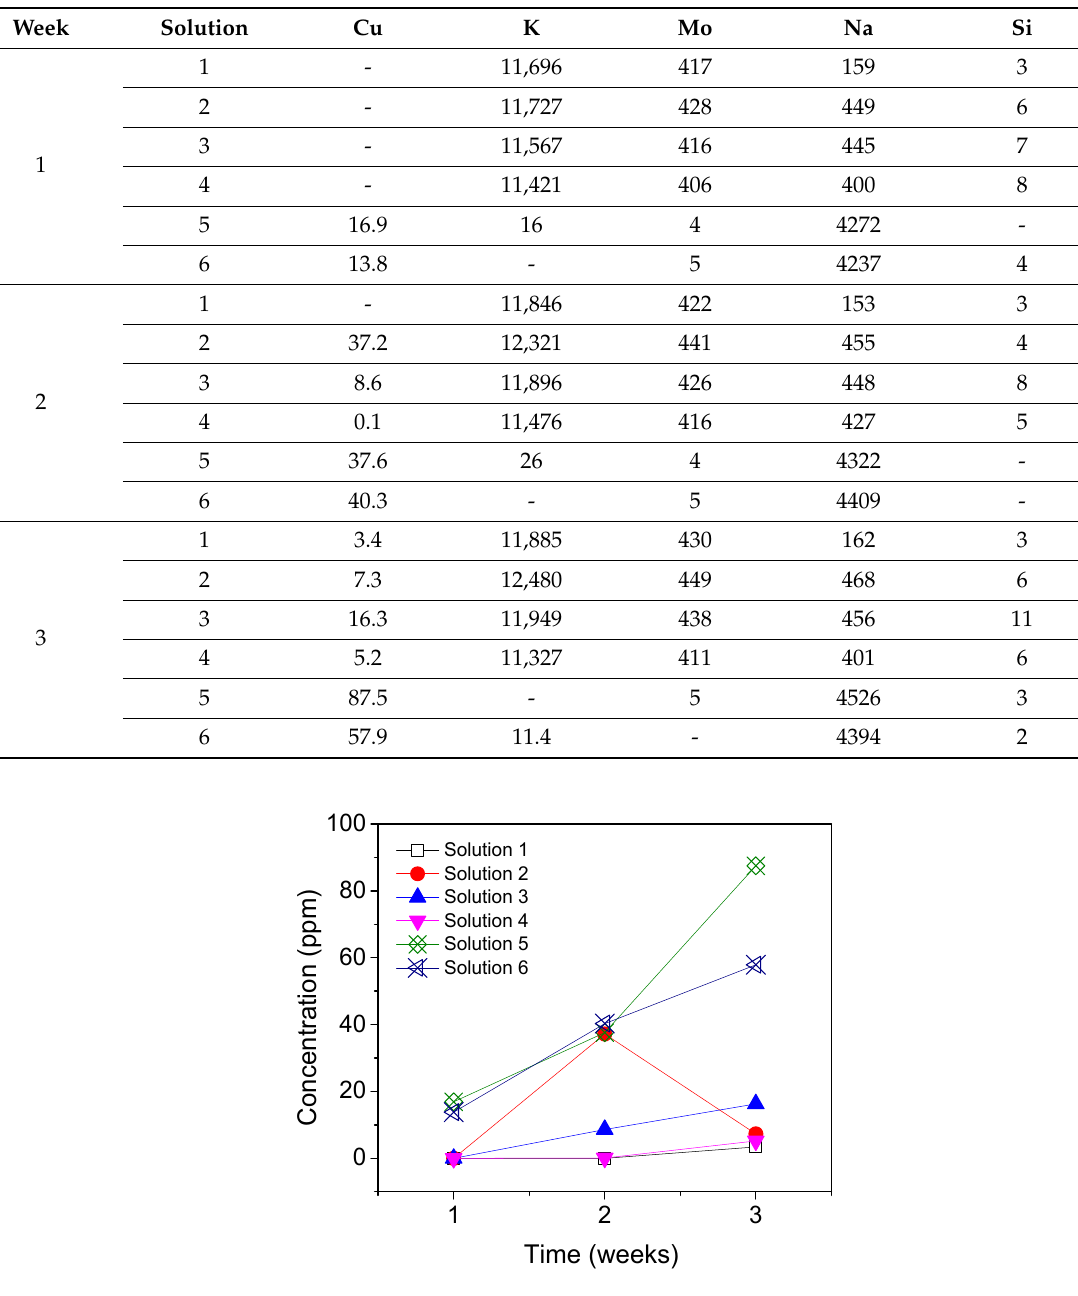
Figure 2. Concentration of Cu ion in the solution as a function of immersion time. After 2 weeks, about 40 ppm of Cu ions were dissolved in solutions no2, no5, and no6. Cu + or Cu 2+ ions are not thermodynamically stable in water with pH 7~13, referring to the Pourbaix diagram [11]. Cu ions form oxides, i.e., Cu 2 O or CuO, by reactions such as 2Cu + + 1/2 O 2 + 2e − → Cu 2 O, 2Cu + + O 2 + 2e − → 2CuO, 2Cu 2+ + 1/2 O 2 + 4e − → Cu 2 O, Cu 2+ + 1/2 O 2 + 2e − → CuO. The concentration of the dissolved Cu ion should be reduced by these reactions, and this is thought to be what happened significantly in solution no2 with high Cu concentration. This result is quite similar to previous work [12], in which the Cu con- centration increased up to 2 weeks and then was almost constant up to 3 weeks in the antifreeze solution with the equivalent composition of no2 in this study. The same com- positions of solutions with No1 and No2 in this work were used for the previous, but the immersion test was performed at 120 °C in [12] but at 98 °C in this work. The Cu concen- tration in the two solutions after 3 weeks was lower in this study than in the solutions with the same composition used in the previous work. Therefore, it is thought that the corrosivity of antifreeze solutions is stronger at higher temperatures and the inhibiting action of the inhibitors A and B is more effective at lower temperature. Furthermore, it is notable that the Cu concentration in the solution with inhibitor A was lower than with inhibitor B up to 1 week in the previous study [12] but it became higher by prolonged test. Both works imply that inhibitor B is more effective in suppressing Cu corrosion than in- hibitor A for a long time of more than 2 weeks. However, the Cu concentration in solution no5 and solution no6 did not decrease, although the concentration is similar to that in solution no2. Inhibitor B, contained in so- lution no2, may be more effective in promoting oxide formation with a high Cu concen- tration in the solution than inhibitor D of solutions no5 and no6. Otherwise, the pH dif- ference (Figure 3) or the content of molybdate and nitrite in the solution might cause this result. The pH of solution no2 is 9.8 after 2 weeks of test, but the pH of solutions no5 and no6 was below 8.0 at all measurement times. The reaction tendency of Cu ions to form